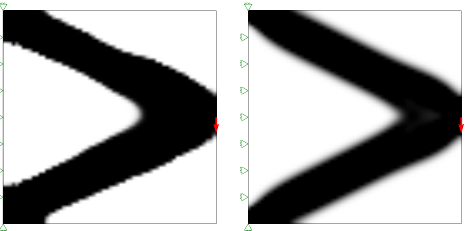
Figure 11. Sample geometry ( Left ): deep learning-based topology optimization by using the predictor–evaluator network (PEN) method. ( Right ): 88 lines of code Andreassen et al.